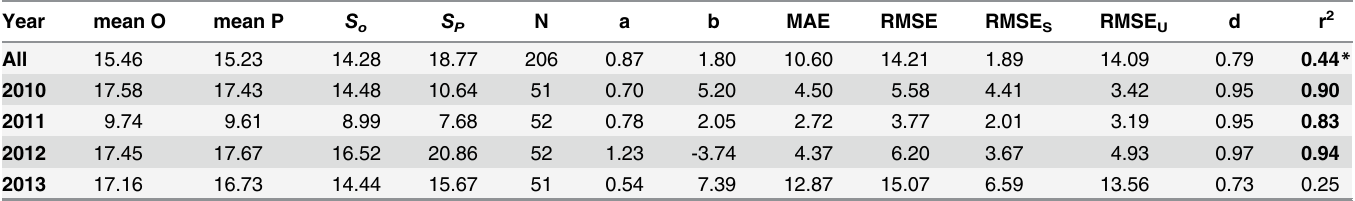
Table 1. Ensemble model validation statistics for the top 1% of simulations for San Juan County, PR parameterized for the entire time period (2010 – 2013) and individual years.